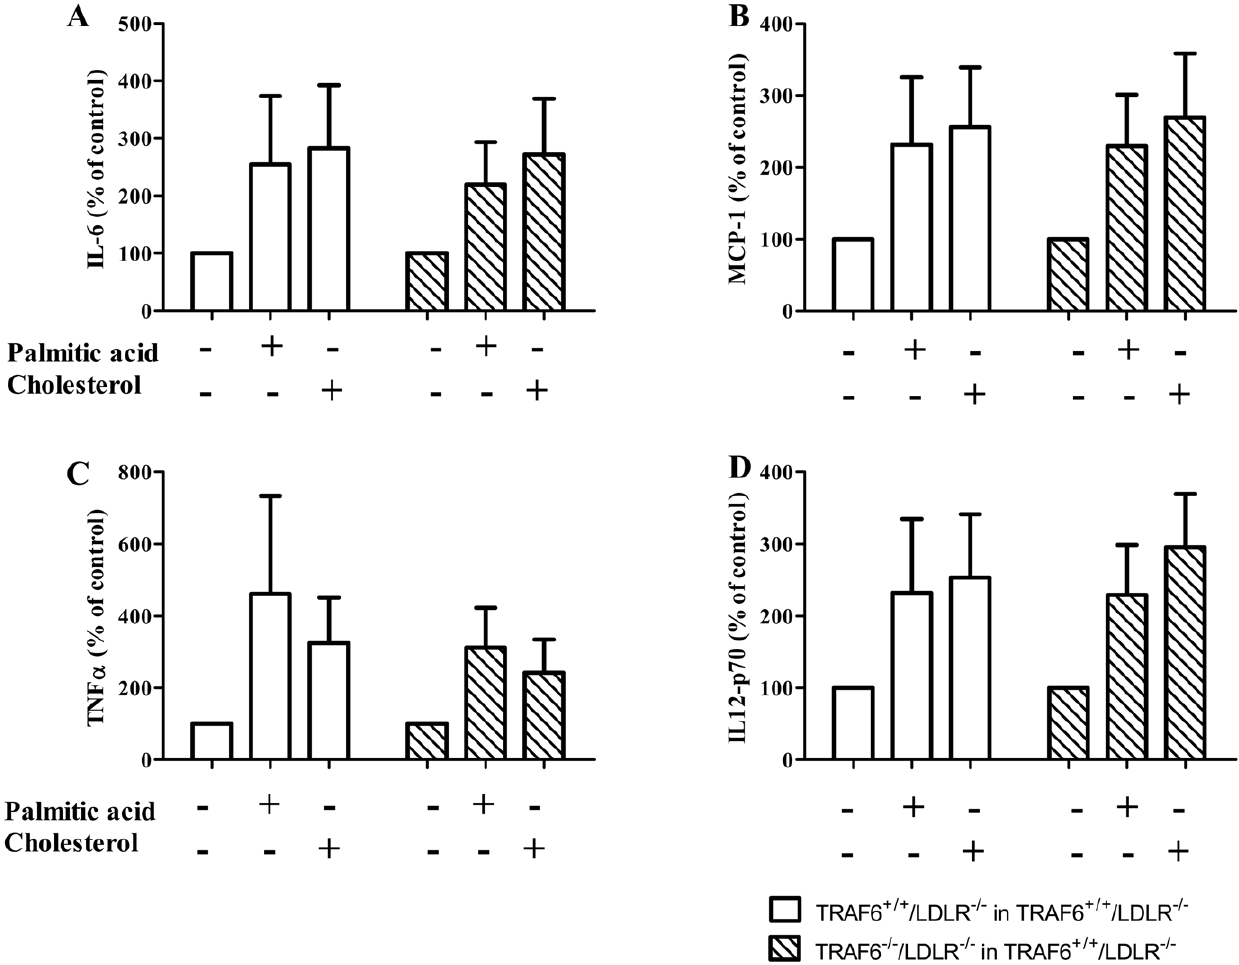
Figure 7. TRAF6 deficiency does not modulate inflammatory reactivity of macrophages toward cholesterol and palmitic acid. Bone marrow-derived macrophages were isolated from 6 week old TRAF6 + / + /LDLR 2 / 2 mice receiving TRAF6-deficient (hatched bars, N=4) or competent fetal liver cells (white bars, N=4), were stimulated with 4 mg/ml cholesterol or 0.75 m M palmitic acid, and assayed for expression of IL-6 (A), MCP-1 (B), TNF a (C), and IL12-p70 (D) by cytometric bead